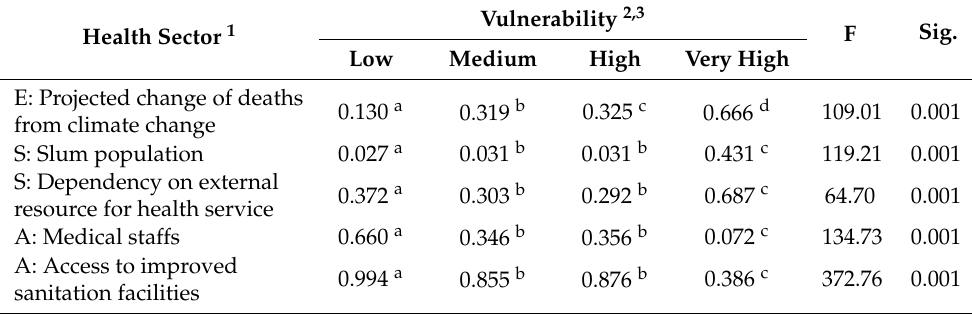
Table 8. Climate change vulnerability classes by health sector vulnerability indicators.